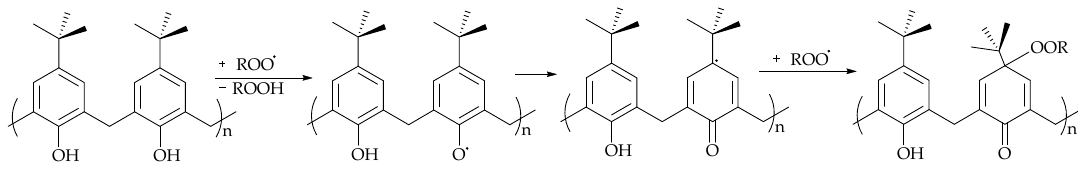
Scheme 1. Mechanism of radical scavenging activity of t-butylcalix[n]arene derivatives.